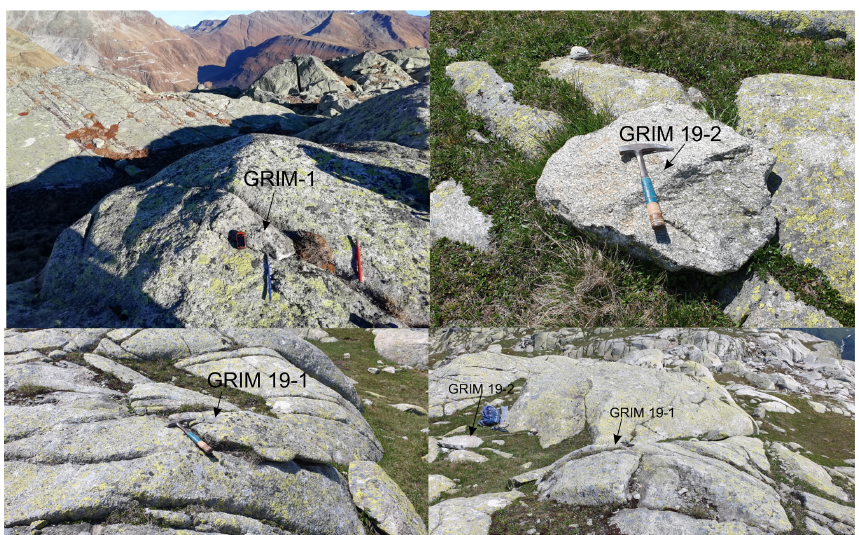
Figure 4. Samples and sampling locations on the Näglisgrätli, Grimsel Pass, Switzerland. Photo of GRIM 1 by Peter M. Abbott and Georgina King; all others by Tibor J. Dunai.